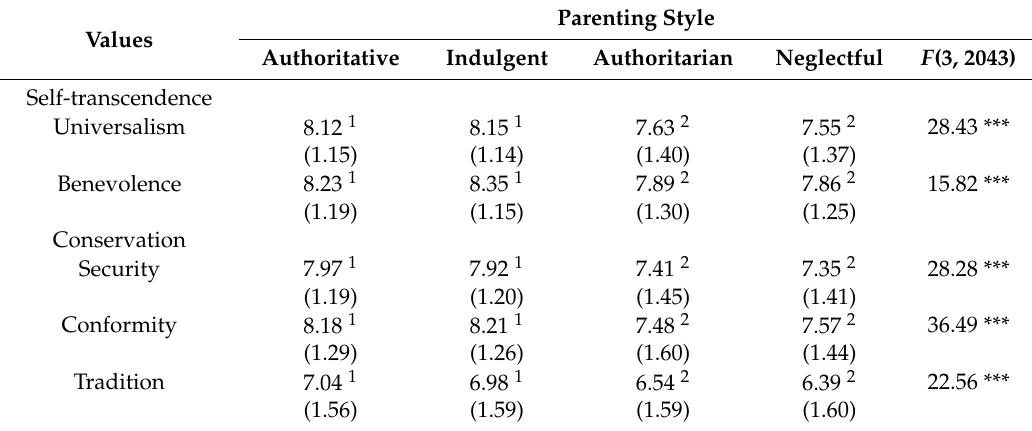
Table 6. Means and (standard deviations) of parenting style, and main univariate F values for value